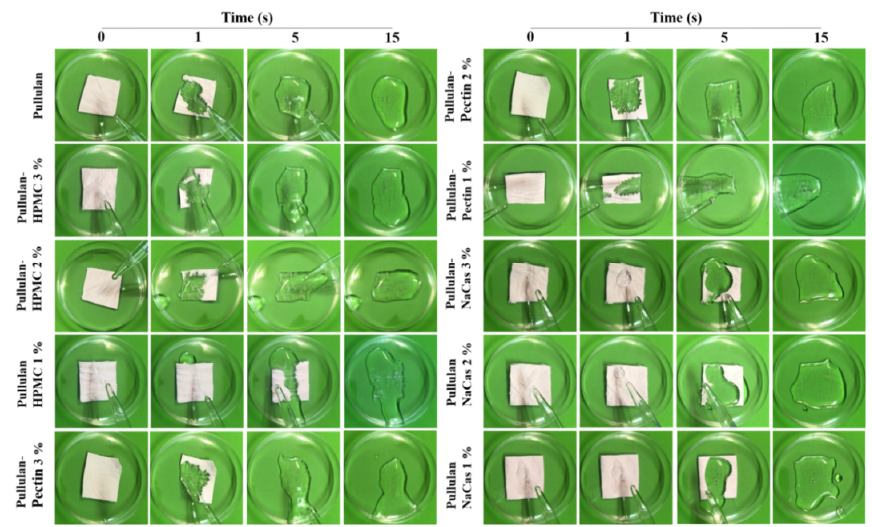
Figure 6. In vitro disintegration profiles of the ODFs in simulated salivary fluid as a function of time.